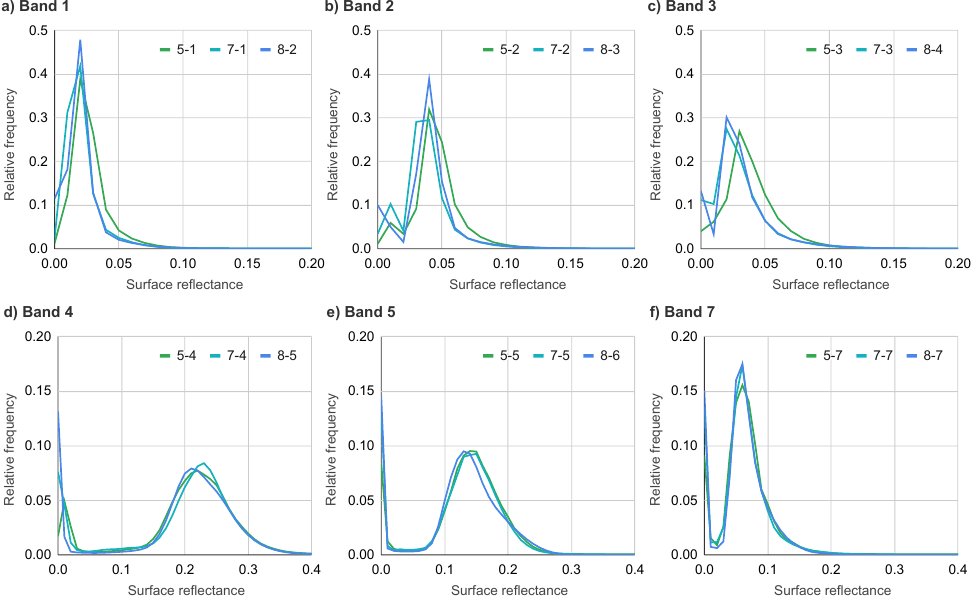
Figure 5. Characteristic histograms of Landsat Level-2 products in bands 1–5, 7 for Landsat-5/7 and the corresponding bands 2–7 for